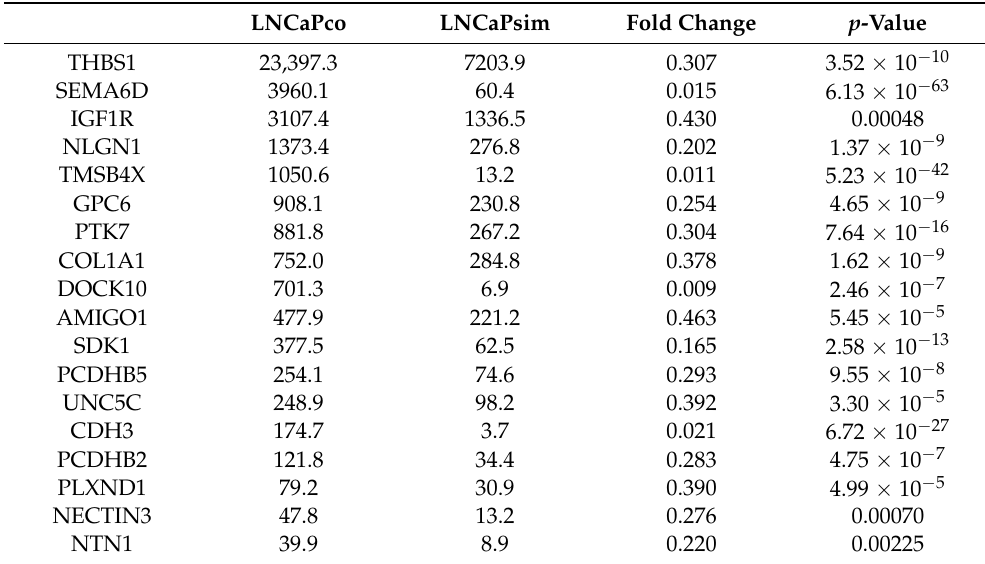
Table 1. List of significantly downregulated genes (fold change < 0.5, n = 3) annotated to cell adhesion and cell migration in LNCaPsim compared to LNCaPco cells.